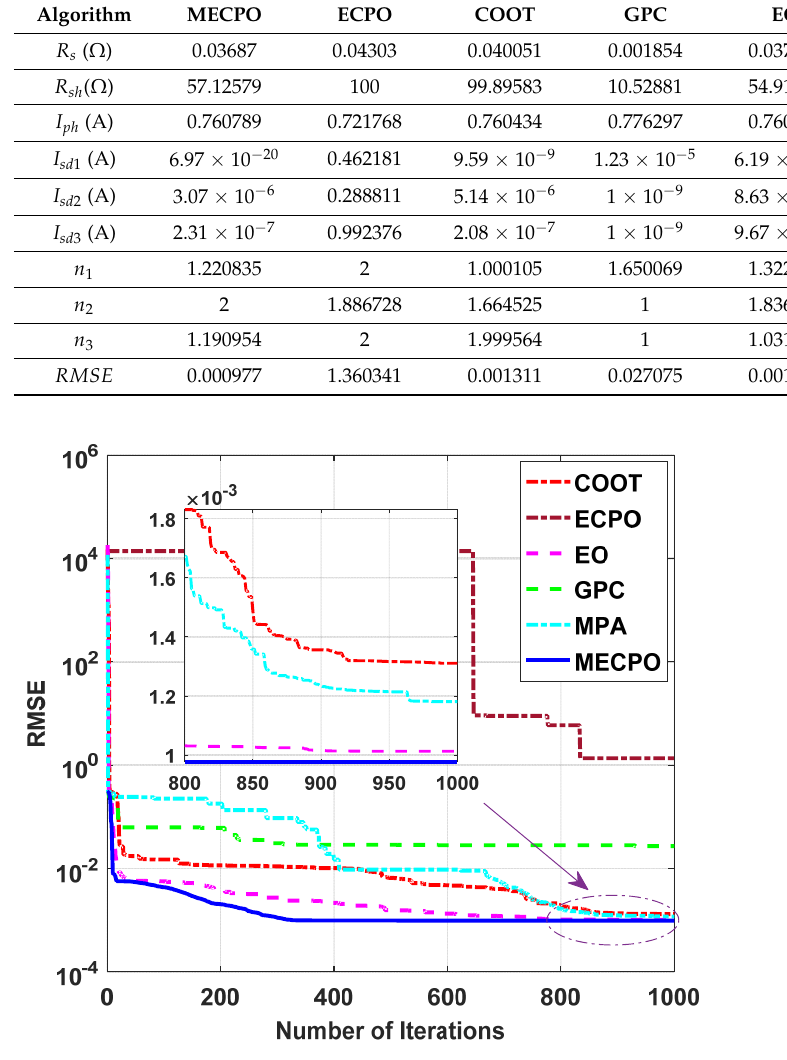
Figure 16. Convergence curve of the MECPO and other recent algorithms for the TDM. Table 13. Statistical results the MECPO technique and other recent algorithms in the case of the